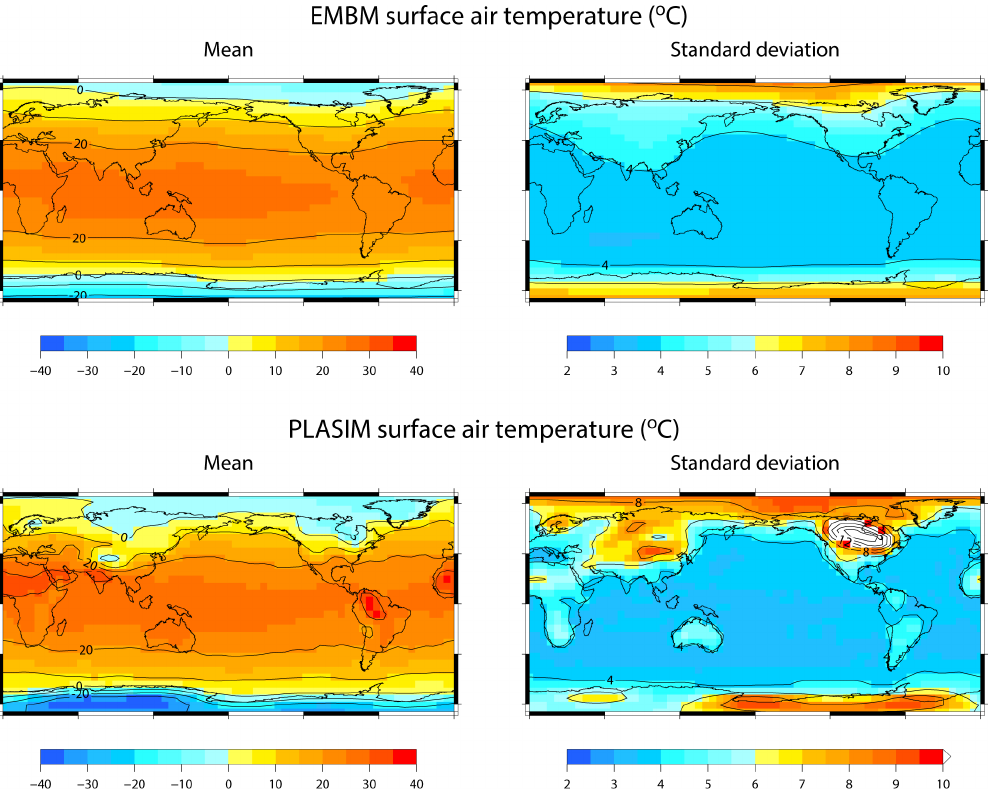
Figure 2. The mean and standard deviation of SAT across the 600-member ensembles of GENIE-1 and PLASIM. There are white cells on the PLASIM SD plot where the outputs go beyond the plotted range. The largest standard deviation in PLASIM is 17.5 ◦ C. The contours on the mean and SD plots are shown every 10 and 4 ◦ C,